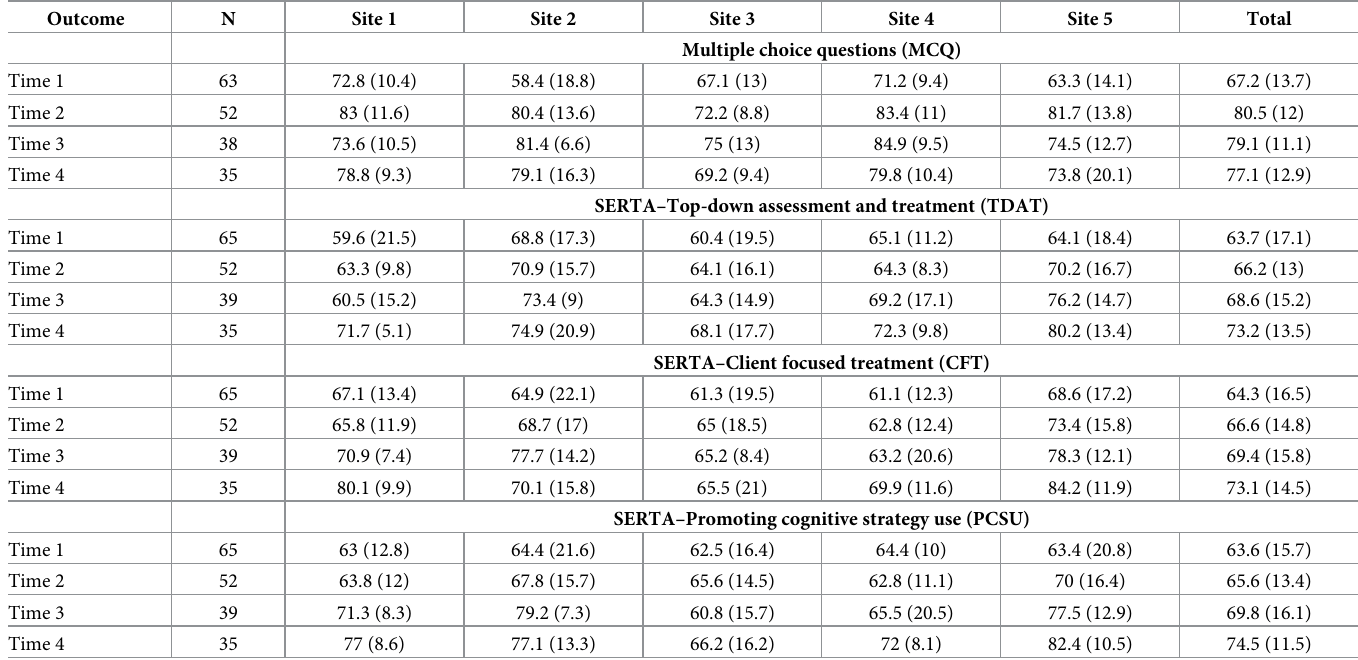
Table 4. Means and standard deviations for MCQ and SERTA data at all time points.